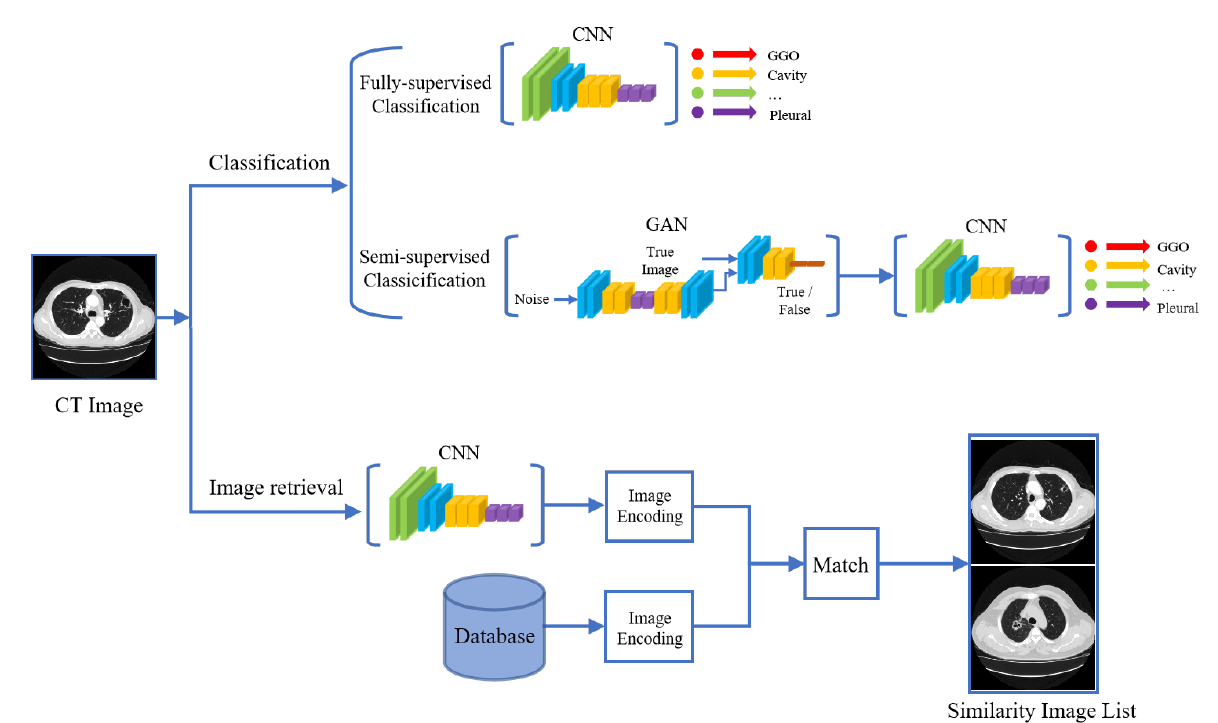
Figure 3. Network frameworks used in deep learning methods: Fully-supervised classification sends the CT images to the convolutional neural network (CNN) for classification and outputs different CISs class; while semi-supervised classification addresses the problem of lack of dataset by using the generative adversarial network (GAN) to generate a large number of high-quality samples to expand the training data and then send them to the convolutional neural network for classification; image retrieval sends the images to the convolutional neural network to extract features and calculate the similarity between these features and the features of the image to be retrieved to return a collection of lesion images similar to the query